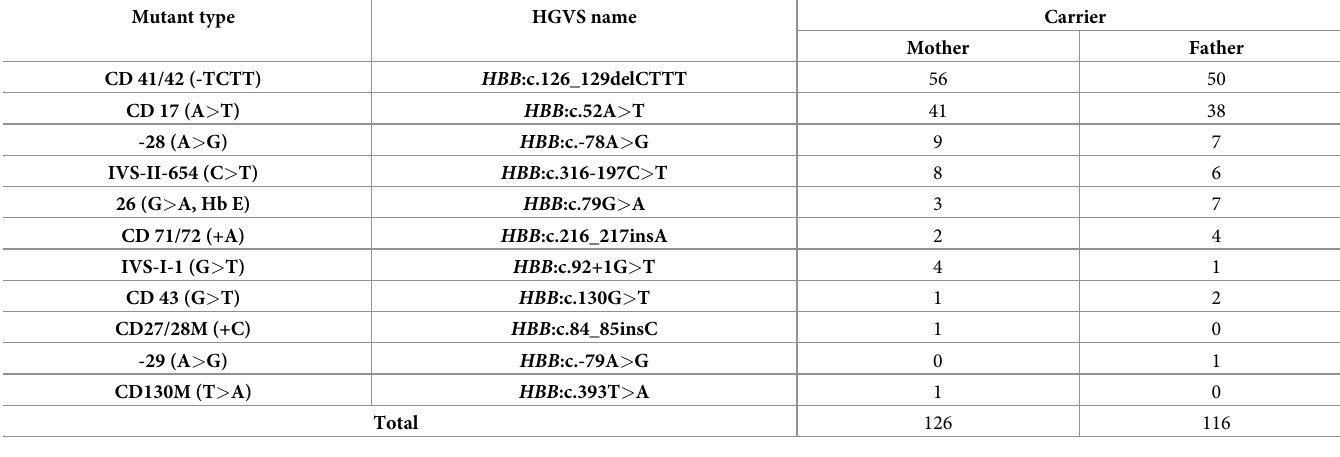
Table 2. The β -thalassemia carrier status of fetal biological parents. Mutant